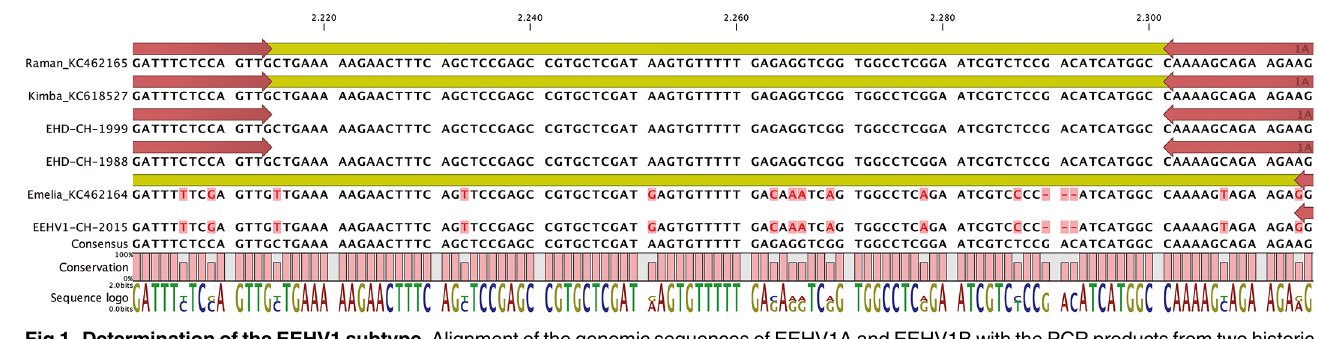
Fig 1. Determination of the EEHV1 subtype. Alignmentof the genomicsequencesof EEHV1A and EEHV1B with the PCR products from two historic Swiss cases of EHD (EHD-CH-1988 and EHD-CH-1999) as well as with a recent Swiss EEHV1 isolate(EEHV1-CH-2015). Kimba and Raman represent two different prototypeviruses of EEHV1A, whereasEmeliais the prototypevirus strain for EEHV1B. Conservedsequencesare lettered in black; non-conserved sequencesare lettered in red. The map positionsof the primer sequencesare indicatedby arrows. (Figure exported from CLC Main Workbench